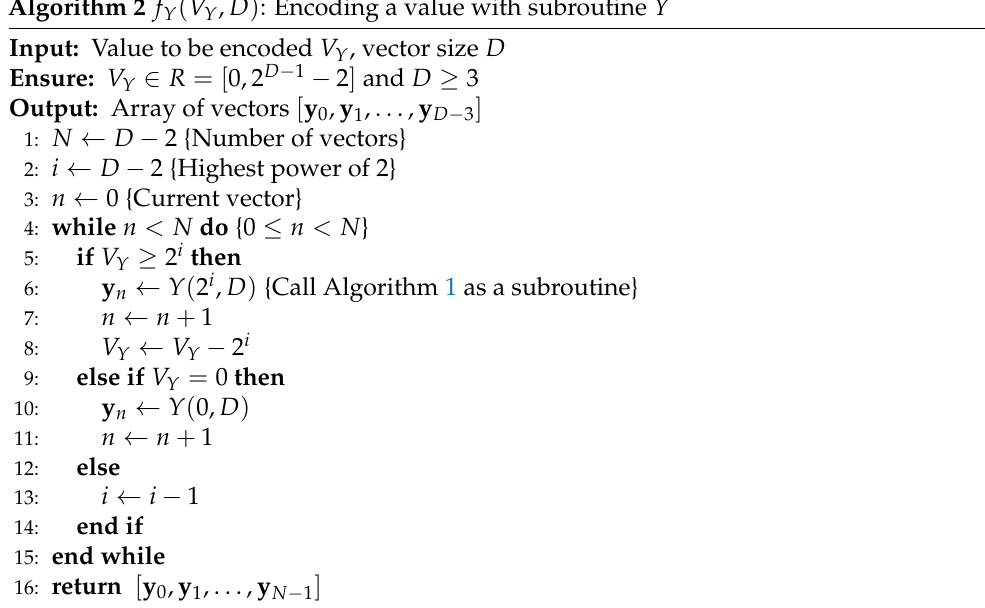
Algorithm 2 f Y ( V Y , D ) : Encoding a value with subroutine